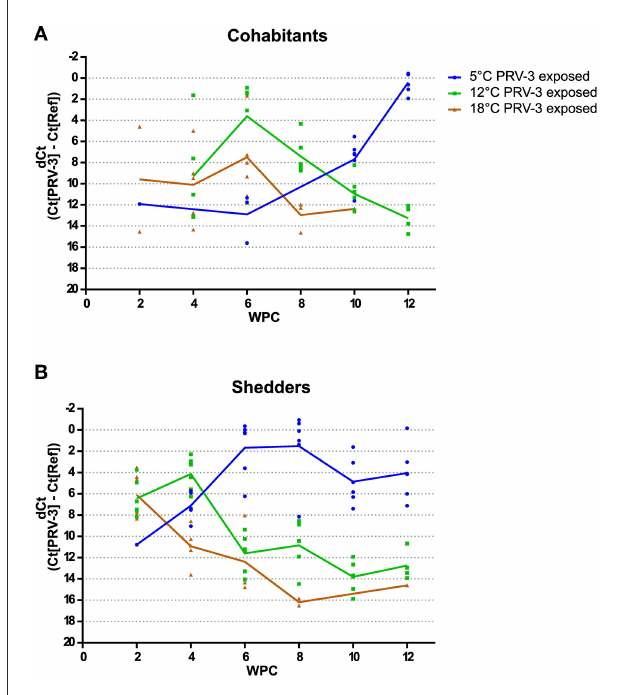
FIGURE2 PRV-3 virus load shown as dCt [= Ct(PRV-3)-Ct(Reference gene)] for (A) cohabitants, and (B) shedders. Only individuals that tested positive are shown on the graphs. In cohabitants, a significant difference in virus load was detected at 5 ◦ C at 12 WPC compared to 6 WPC at 12 and 18 ◦ C (time point of highest virus load, p = 0.024 and p = 0.009, respectively). Similar tendency was observed in the shedders: at 5 ◦ C 8 WPC, a significantly higher amount of virus was detected compared to 2 WPC at 18 ◦ C and 4 WPC at 12 ◦ C ( p = 0.041 and p = 0.026,